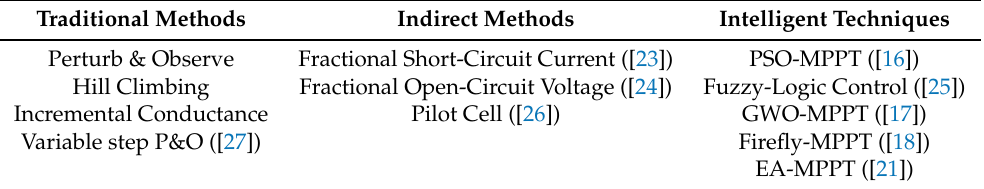
Table 1. Simple classification of MPPT